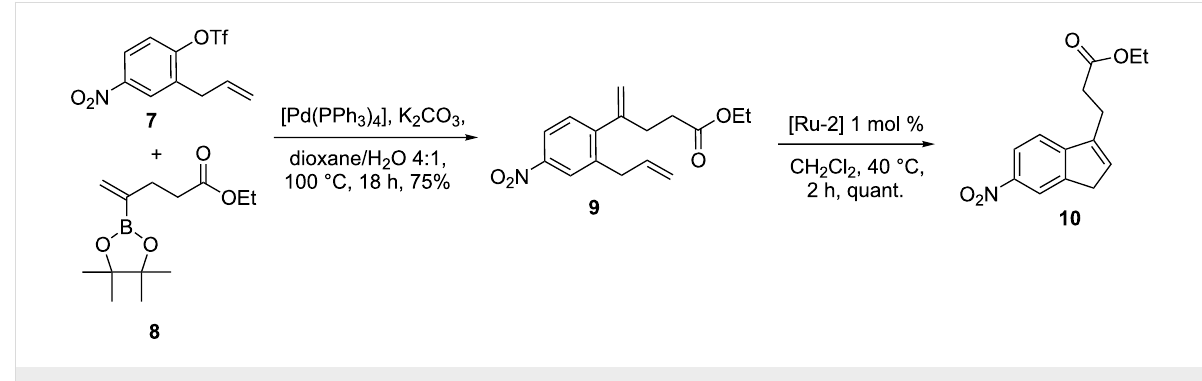
Scheme 1: SM coupling and RCM protocol to substituted indene derivative 10